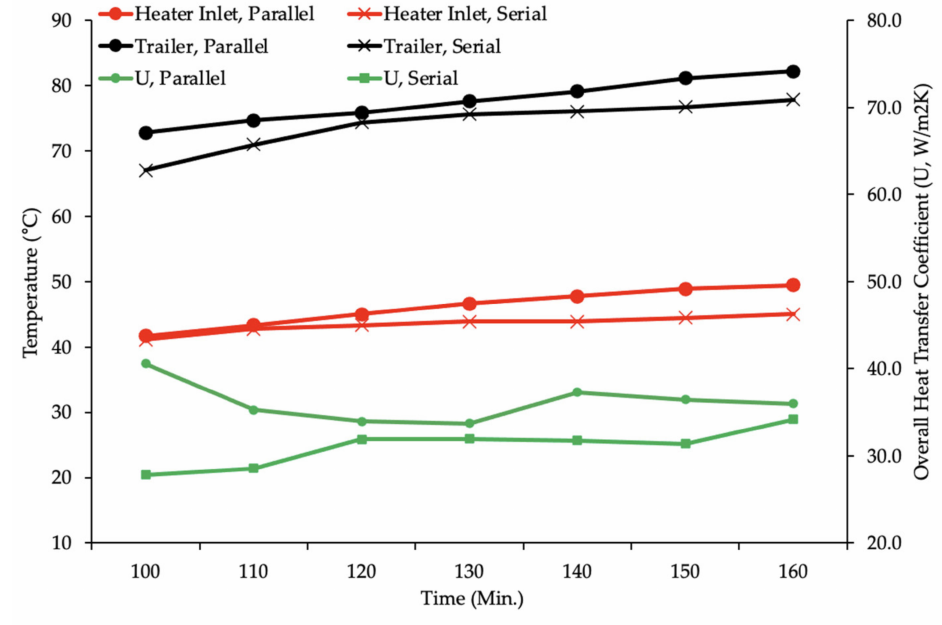
Figure 9. Effect of water-to-air heater arrangement on the system